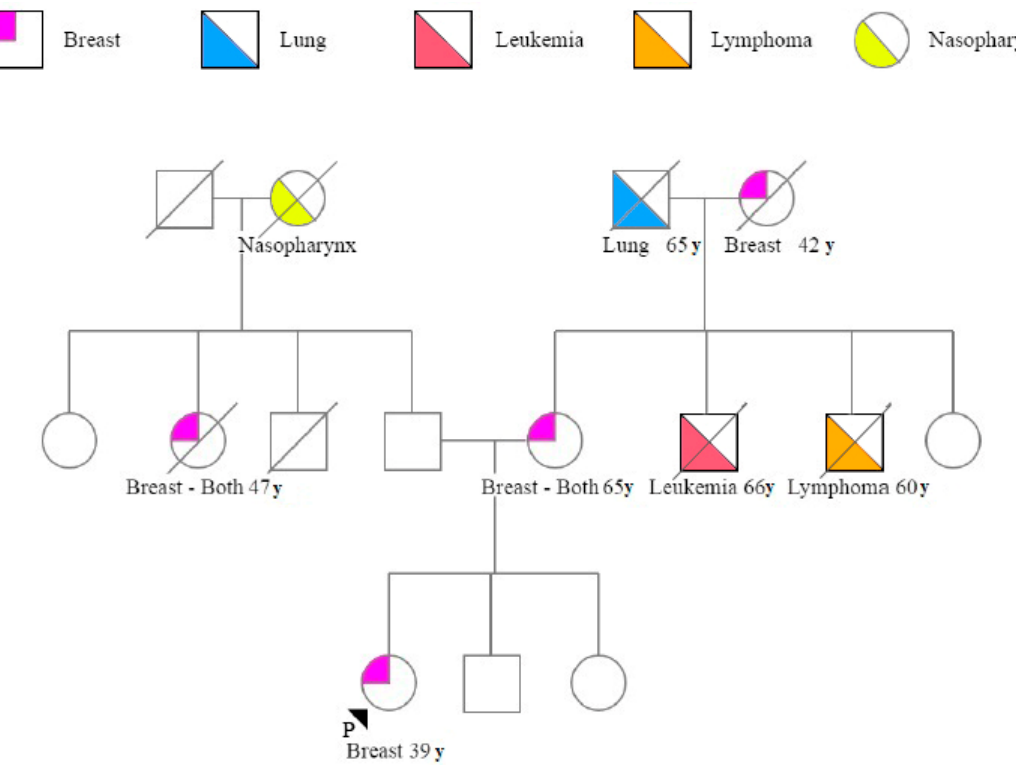
Figure 2. Pedigree of patient ID 886 with c.4928T>C, p.(Val1643Ala) Unclassified variant in BRCA2 gene. The proband is indicated by a black arrow. Cancer Type and age at cancer diagnosis is indicated in the legend. Symbols: squares = males, circles = females; quadrant shading = cancer affected; slash through square or circle = deceased.